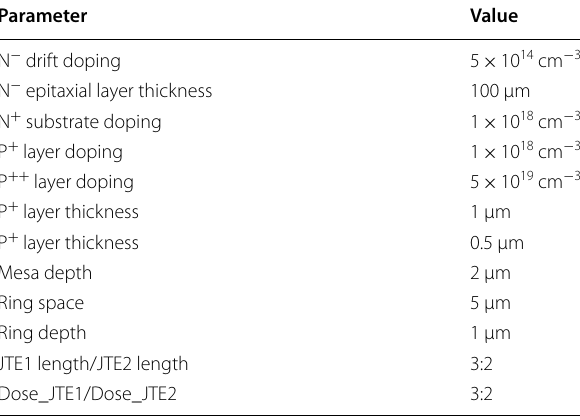
Table 1 Structure parameters of the CFM-JTE 4H-SiC PiN rectifier Parameter